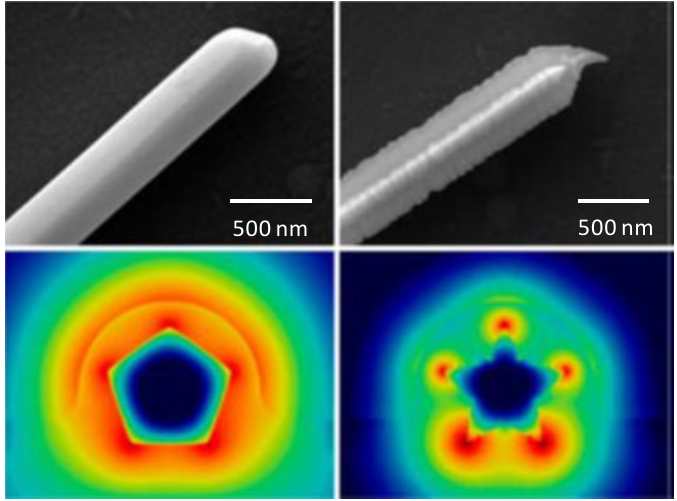
Figure 9. GNWs with pentagonal section and five-point star cross section. Reprinted with permission from [110]. Copyright 2014, American Chemical